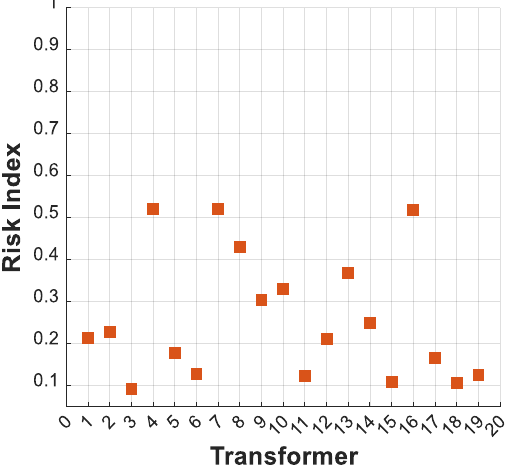
Figure 13. Risk Index of each unit employing the HI*II approach.